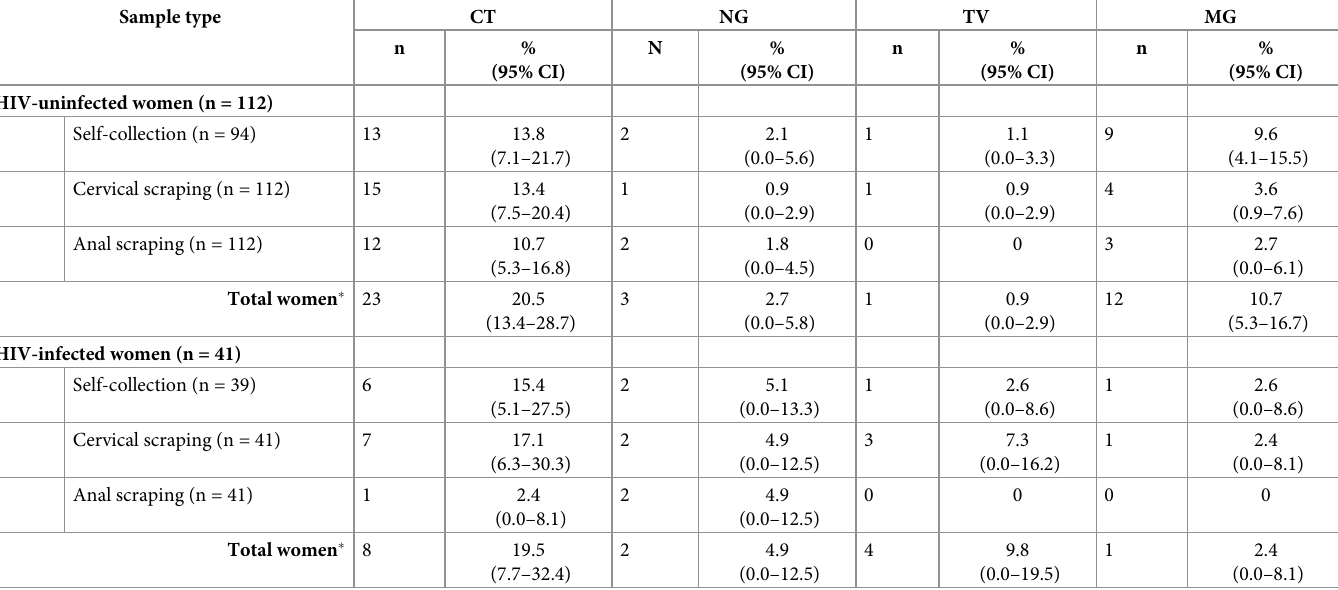
Table 2. Prevalence of STIs in cervico-vaginal self-collection, cervical scraping and anal scraping samples. Sample type